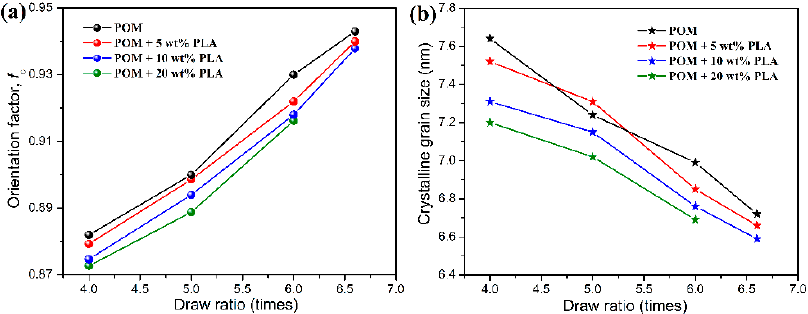
Figure 10. ( a ) C -axis crystalline orientation factors, and ( b ) grain sizes of pure POM fiber and POM/PLLA bicomponent fibers at different draw ratios.